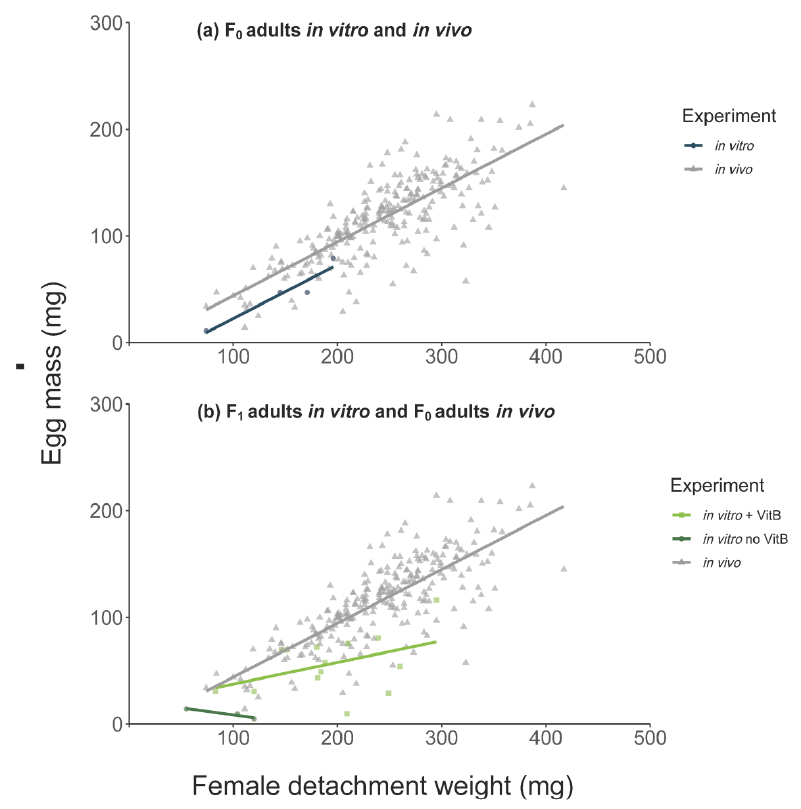
Figure 3. Egg mass (mg) and female detachment weight (mg) from ( a ) F 0 in vitro and in vivo ticks and ( b ) F 1 in vitro (water bath, with and without vitamin B) and F 0 in vivo -fed ticks.